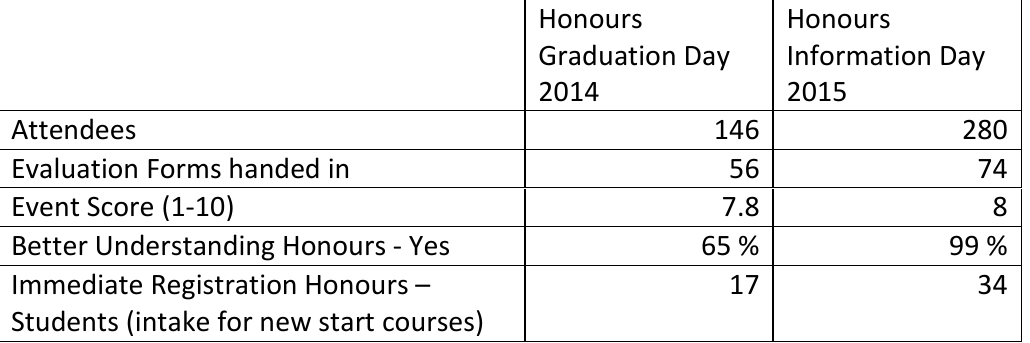
Table 1 Evaluation